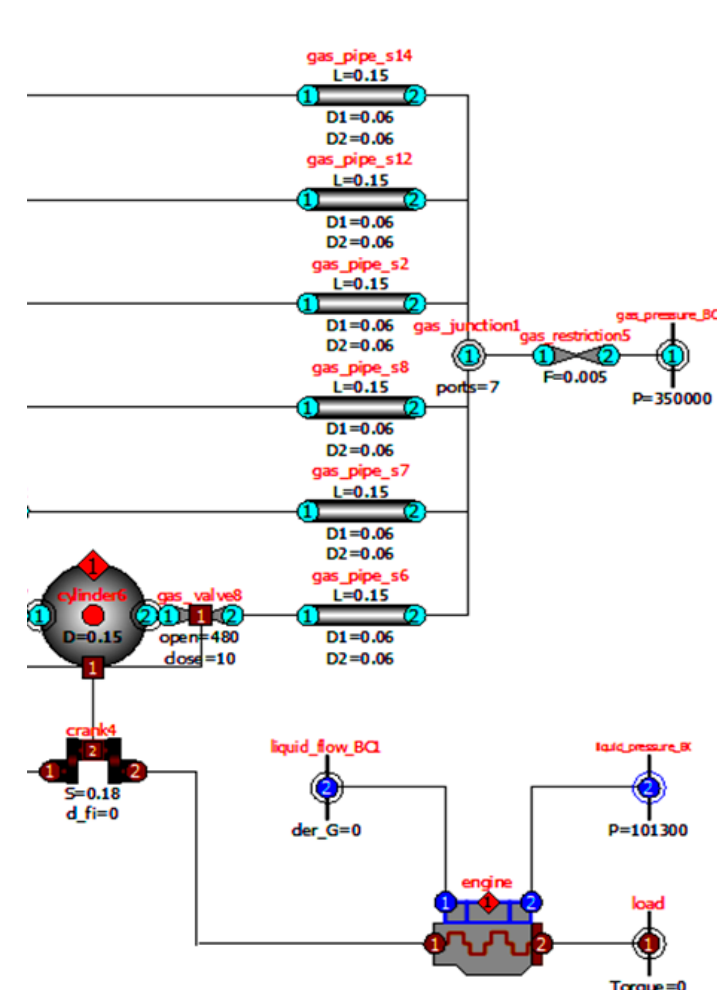
Figure 1. The design scheme of the gas-air path of a diesel engine with fuel and water injection: ( a ) beginning; ( b ) continuation; ( c ) ending. (Source: Authors).